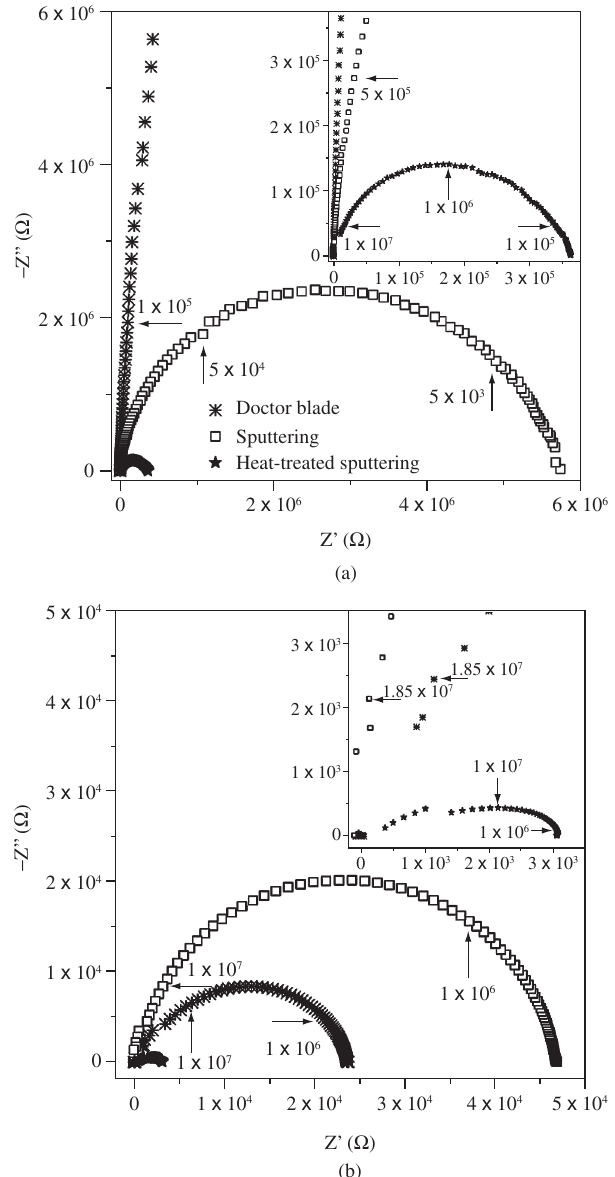
Figure 5. Nyquist plots of the films measured in air at a) 50 °C and b) 350